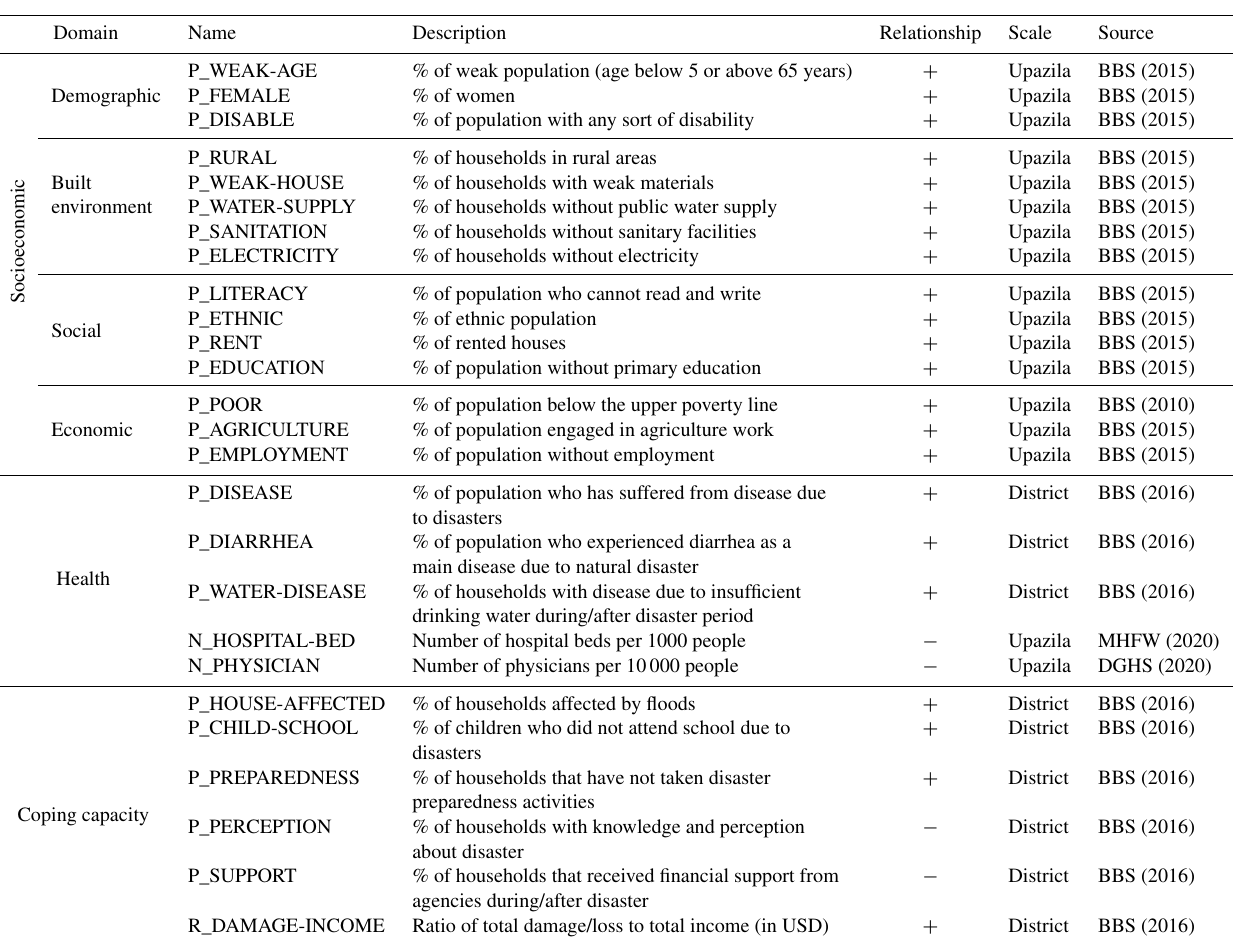
Table 2. Selected indicators for vulnerability